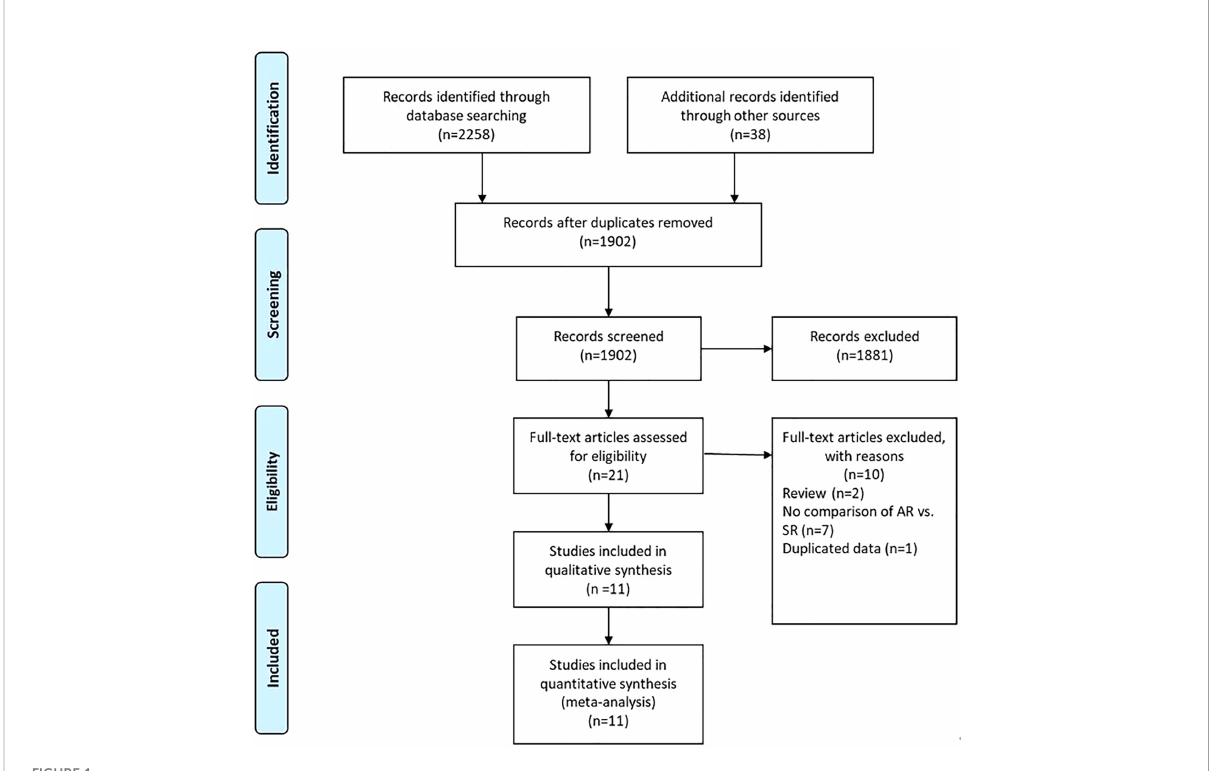
FIGURE 1 The PRISMA Flowchart of study